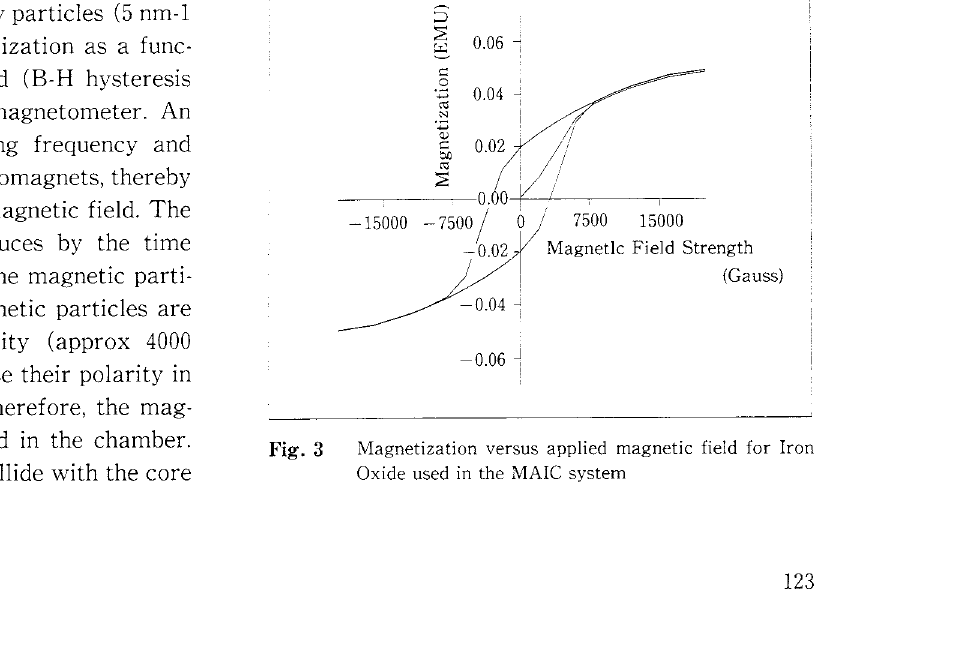
Magnetization versus applied magnetic field for Iron Oxide used in the MAIC